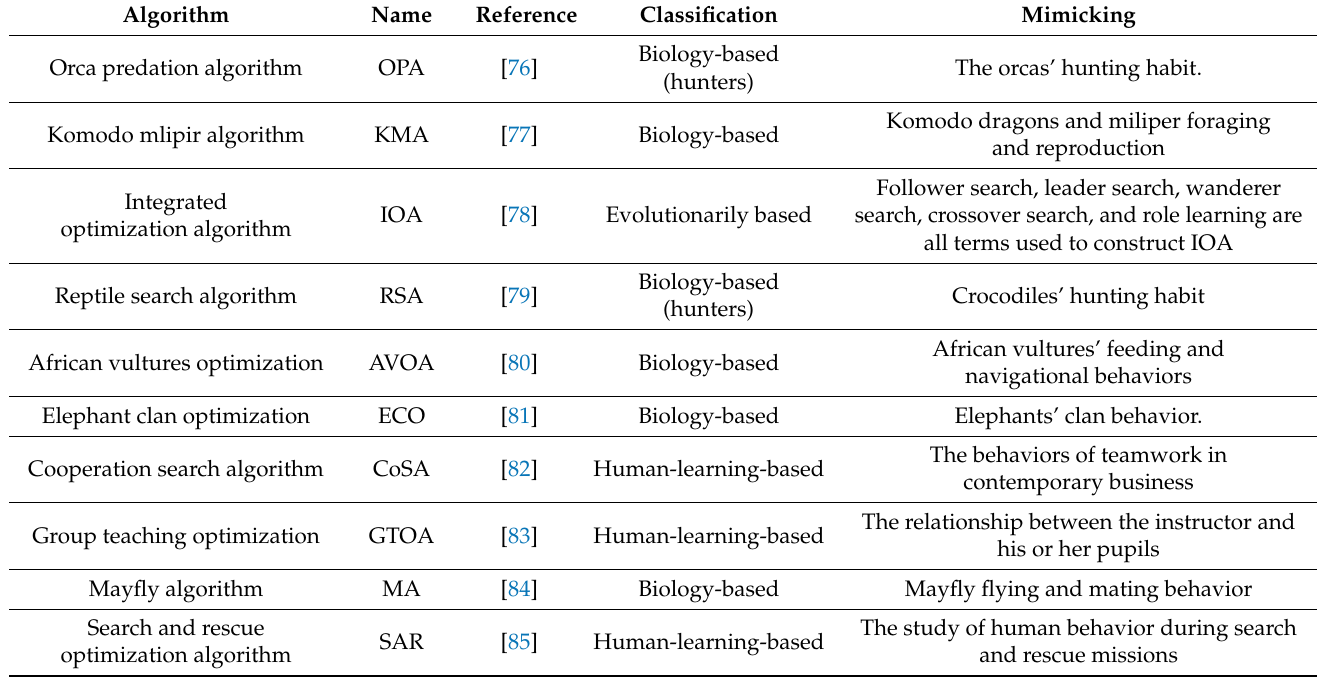
Table 1. State of the art metaheuristic